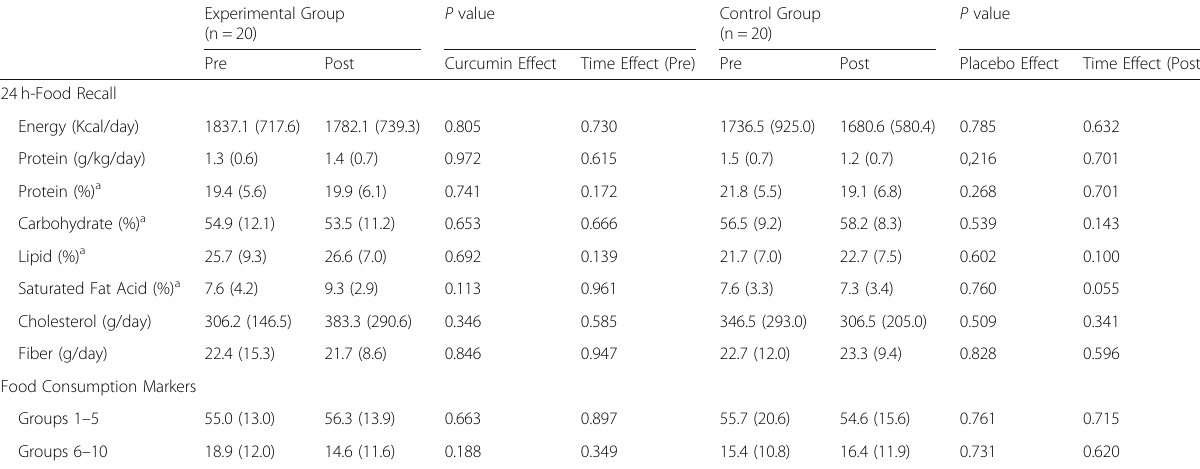
Table 2 Dietary intake of people living with